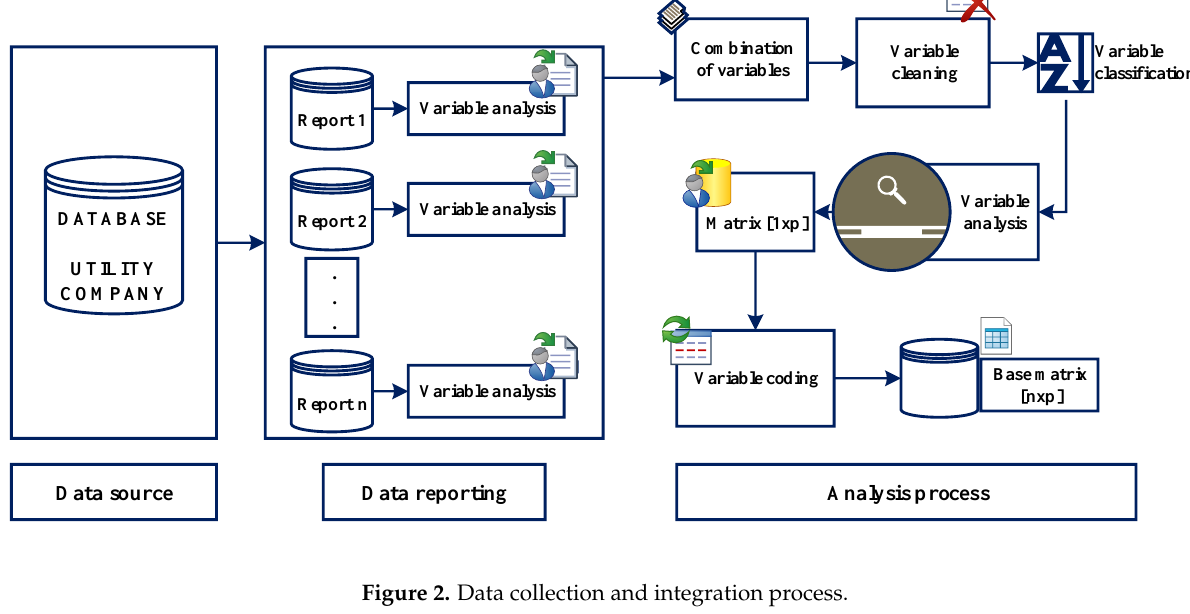
Figure 2. Data collection and integration